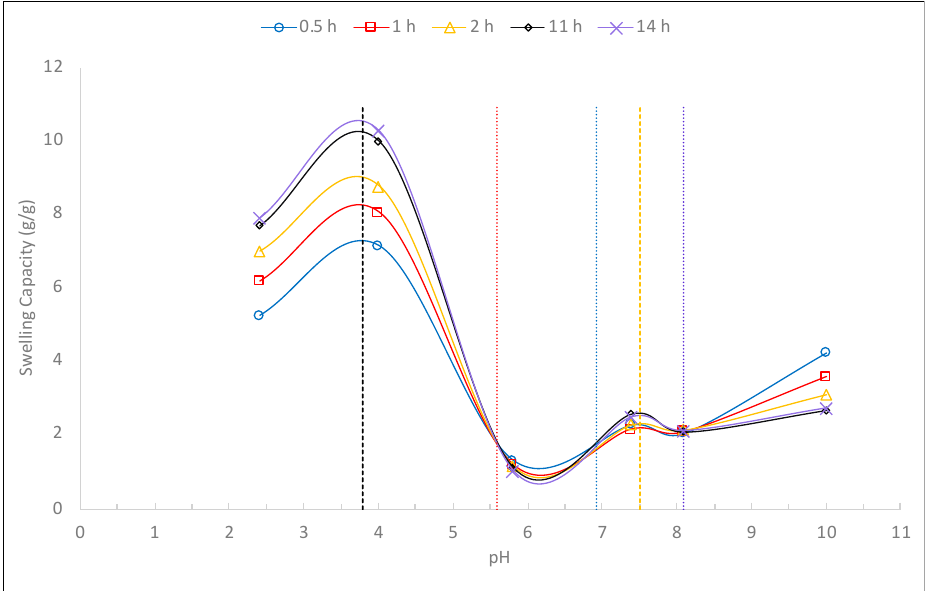
Figure 6. Effects of pH and swelling time on the swelling behavior of CS-MB. Conditions: 6.7 ± 0.3 mg and thickness of 0.05 mm of hydrogel, 5 mL buffered solution, and T = 22 °C.